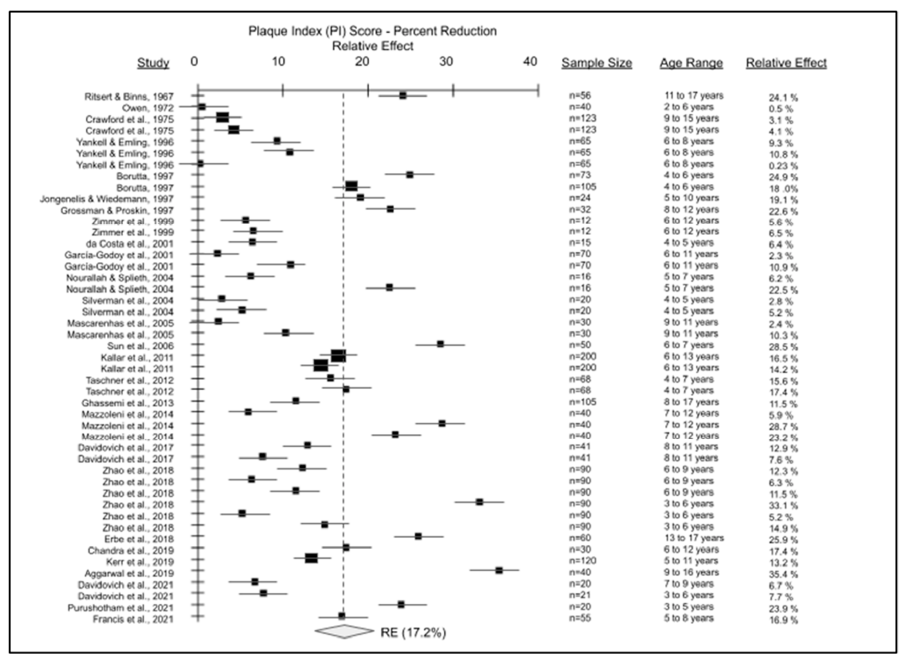
Figure 3. Forest plot of pediatric, non-orthodontic studies of manual versus electric toothbrushing comparing plaque index (PI). A total of 27 studies were evaluated with sample sizes ranging from n = 12 to n = 200 were plotted to determine an average reduction in plaque index or relative effect (RE) with electric toothbrush use of approximately 17.2%, p = 0.0073 [22–48]. To determine if any relationship exists between the relative effect and the mean or